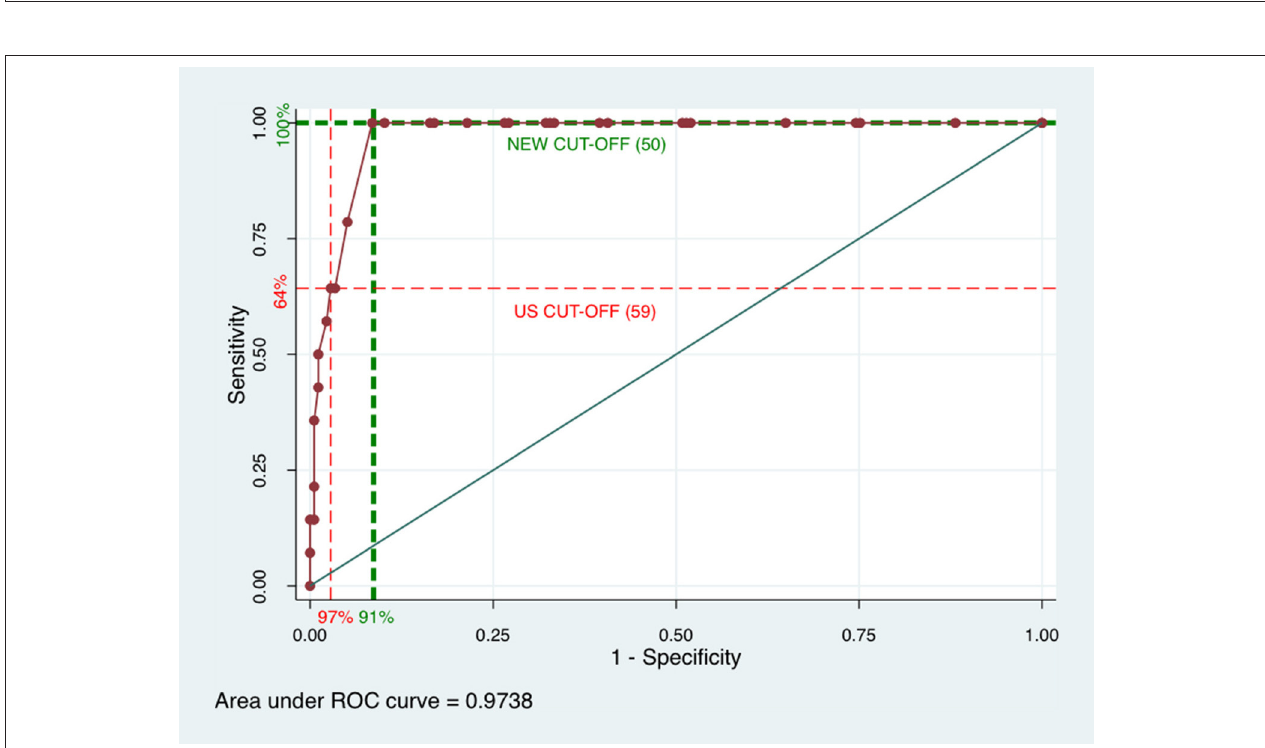
FIGURE 2 | Receiver Operating Characteristics (ROC) curve for ASQ:SE and SDQ in a population-based study of 3-year olds. ASQ:SE, Ages and Stages Questionnaires: Social-Emotional for 36-month interval, first edition; SDQ, Strengths and Difficulties Questionnaire, 2–4 year version.